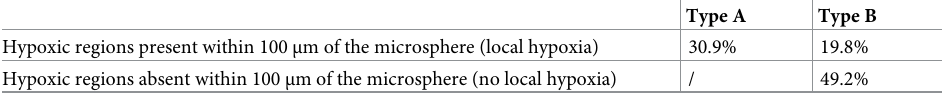
Table 3. Percentage of cases of type A and type B hypoxic intensity with or without hypoxic regions within 100 μ m of the